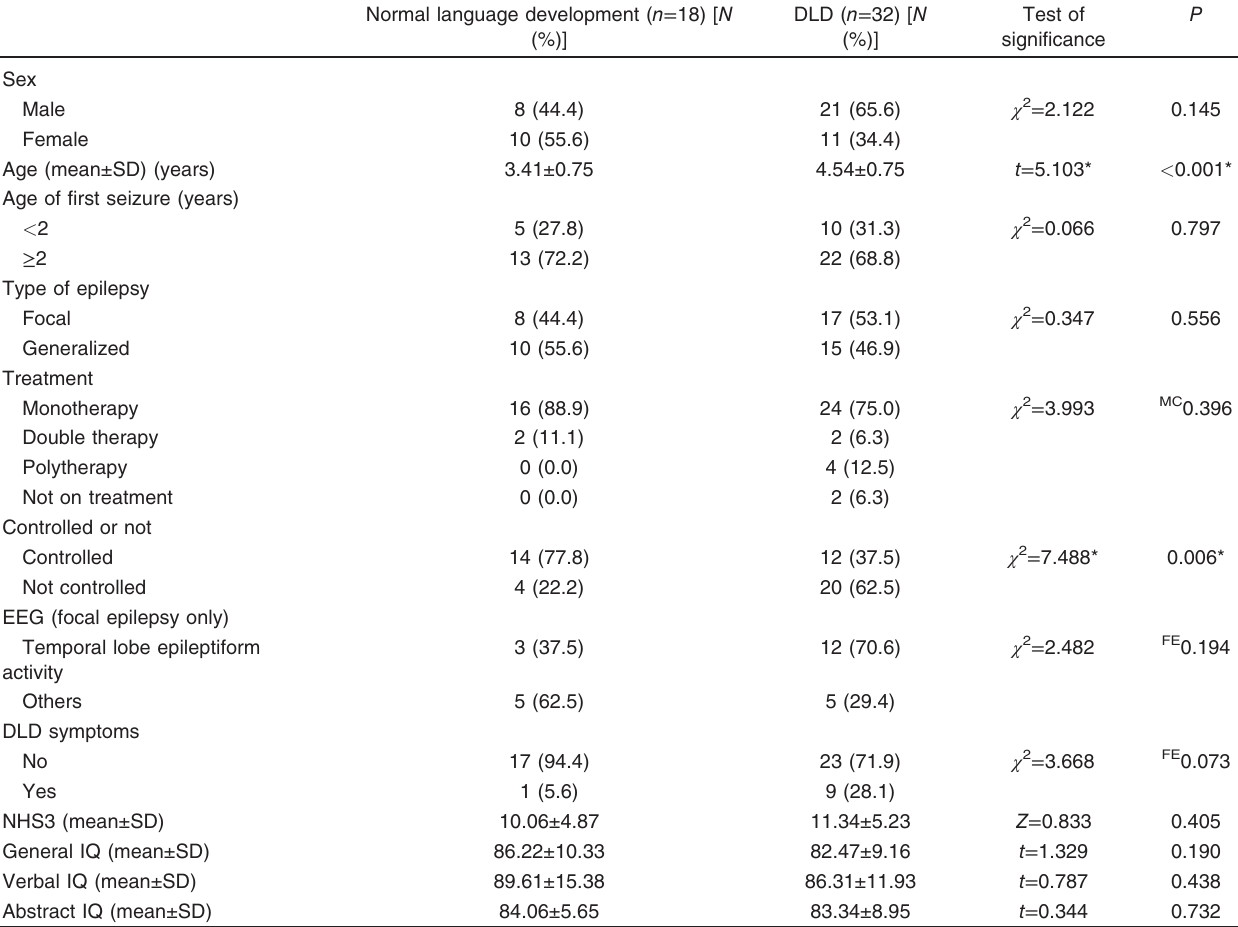
Table 7 The distribution of the presence or absence of developmental language disorders related to variables such as sex, age, age at first seizure, type of seizure, treatment regimen, controlled or not, complaint of developmental language disorder symptoms, electroencephalographic results (focal epilepsy group only), NHS3, and intelligence quotient Normal language development ( n = 18) [ N